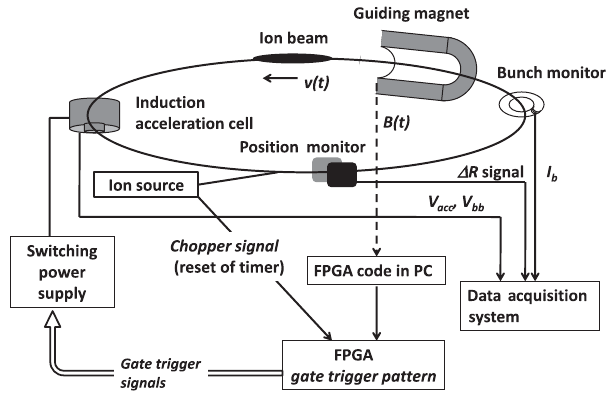
FIG. 2 Flow chart for the induction acceleration system control and data acquisition